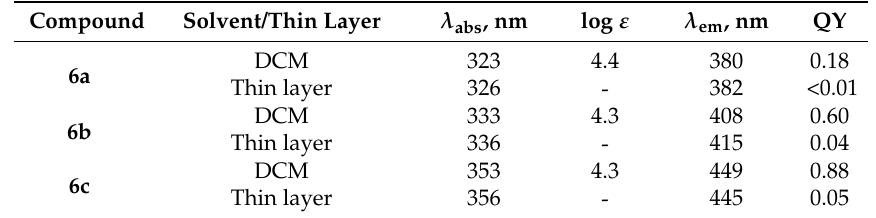
Table 1. Photophysical properties of target compounds 6a – c.